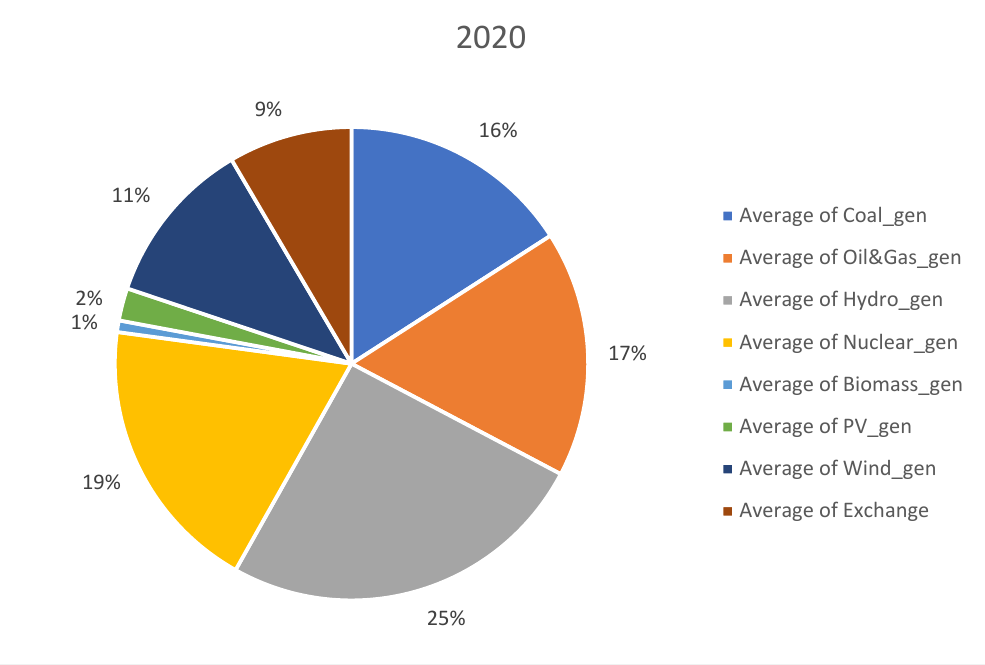
Figure 2. Distribution of generation sources in 2020.